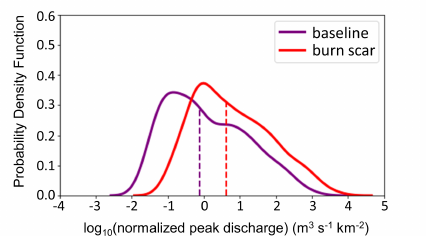
Figure 10. Distributions of peak discharge at the outlet of the 404 catchments normalized by upstream catchment areas within Dolan burn scar in the baseline simulation (purple line) and in the burn scar simulation (red line). Vertical dashed lines indicate me- dian values. We conduct similar analyses using accumulated dis- charge volume in Fig. B7 in Appendix